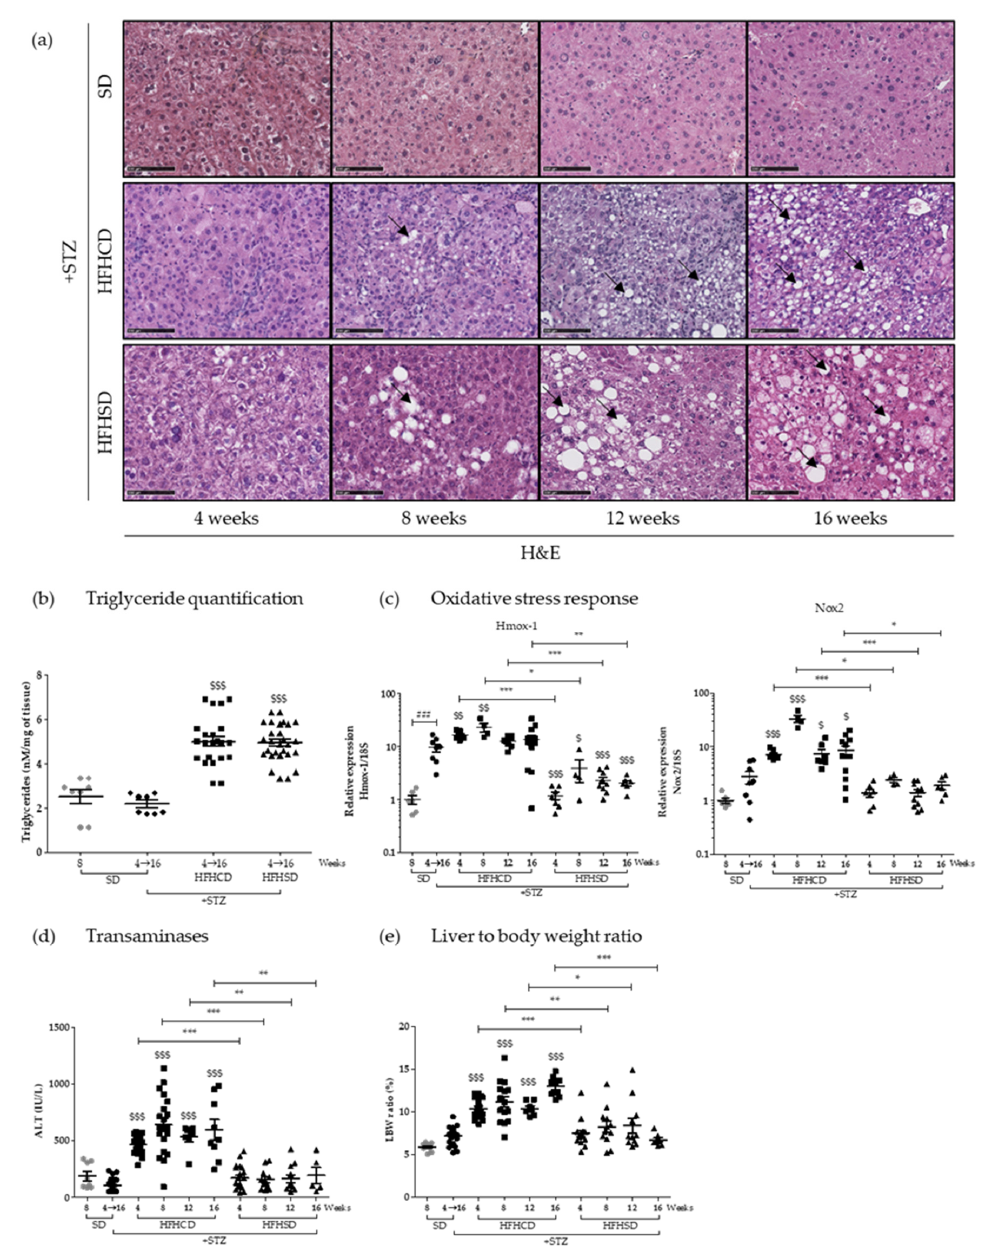
Figure 1. High-fat diet type influenced hepatitis severity in diabetic mice without affecting the steatosis grade. Healthy or diabetic (streptozotocin (STZ)) C57Bl6/J male mice were fed either a standard diet (SD), a high-fat-high-cholesterol diet (HFHCD) or a high-fat-high-sugar diet (HFHSD) during 4, 8, 12 or 16 weeks. ( a ) H&E staining of liver sections. Black arrows show lipid macrovesicles. Scale bars: 100 µm, original magnification ×200; ( b ) triglyceride concentrations measured in liver extracts; ( c ) hepatic mRNA expression levels of Hmox-1 and Nox2 genes; ( d ) plasma alanine transaminase (ALT) concentrations (IU/L) and ( e ) liver to body weight (LBW) ratio, percentage of liver weight on body weight. For all graph, each grey dots, black dots, black squares and black triangles represent individuals from the different groups: healthy mice under SD, diabetic mice under SD, diabetic mice under HFHCD or HFHSD, respectively. ###, p < 0.001 compared diabetic mice under